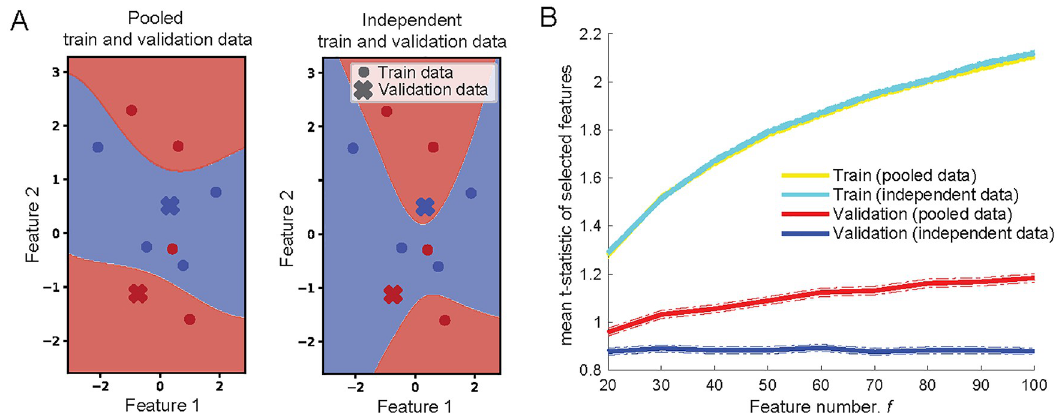
Fig 8. Illustrative examples of why models overfit. A : SVM-RBF decision boundary. Red and blue circles/crosses show data points from two classes, red and blue areas show learned decision boundary by SVM-RBF. Left : Classifier trained on both train data points (circles) and validation data points (crosses). Right : Classifier trained only on train data points (circles). B : Two-sample t -test feature selection performed both, on pooled and on independent train and validation data. Y axis shows mean t -statistic for selected 10 features from the pool of features ranging from 20 to